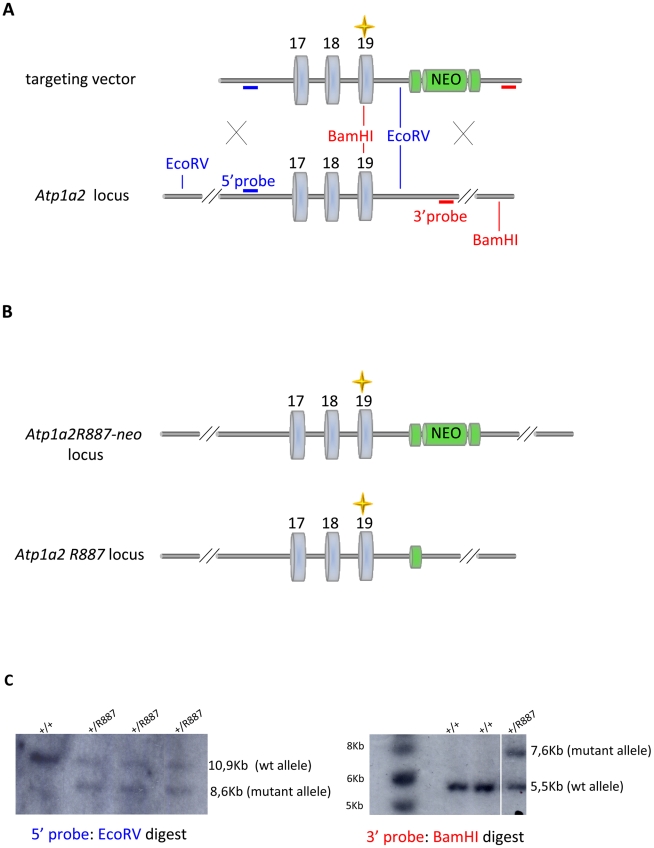
Knock-in construct strategy.A. Genomic structure of the targeting vector and wt Atp1a2 allele. B. Predicted structure after homologous recombination (Atp1a2R887-neo allele), and after Flp-mediated deletion of the neo-cassette (Atp1a2R887 allele). FRT sites are indicated by green circles. Grey boxes indicate respective exons, and yellow star the R887 mutation in exon19. C. Southern blot of F1 Atp1a2+/R887
-neo mutant mice. EcoRV and BamHI-digested genomic DNA from two genotypes for wild-type and Atp1a2+/R887neo mutant strains probed 5′ and 3′ probe.